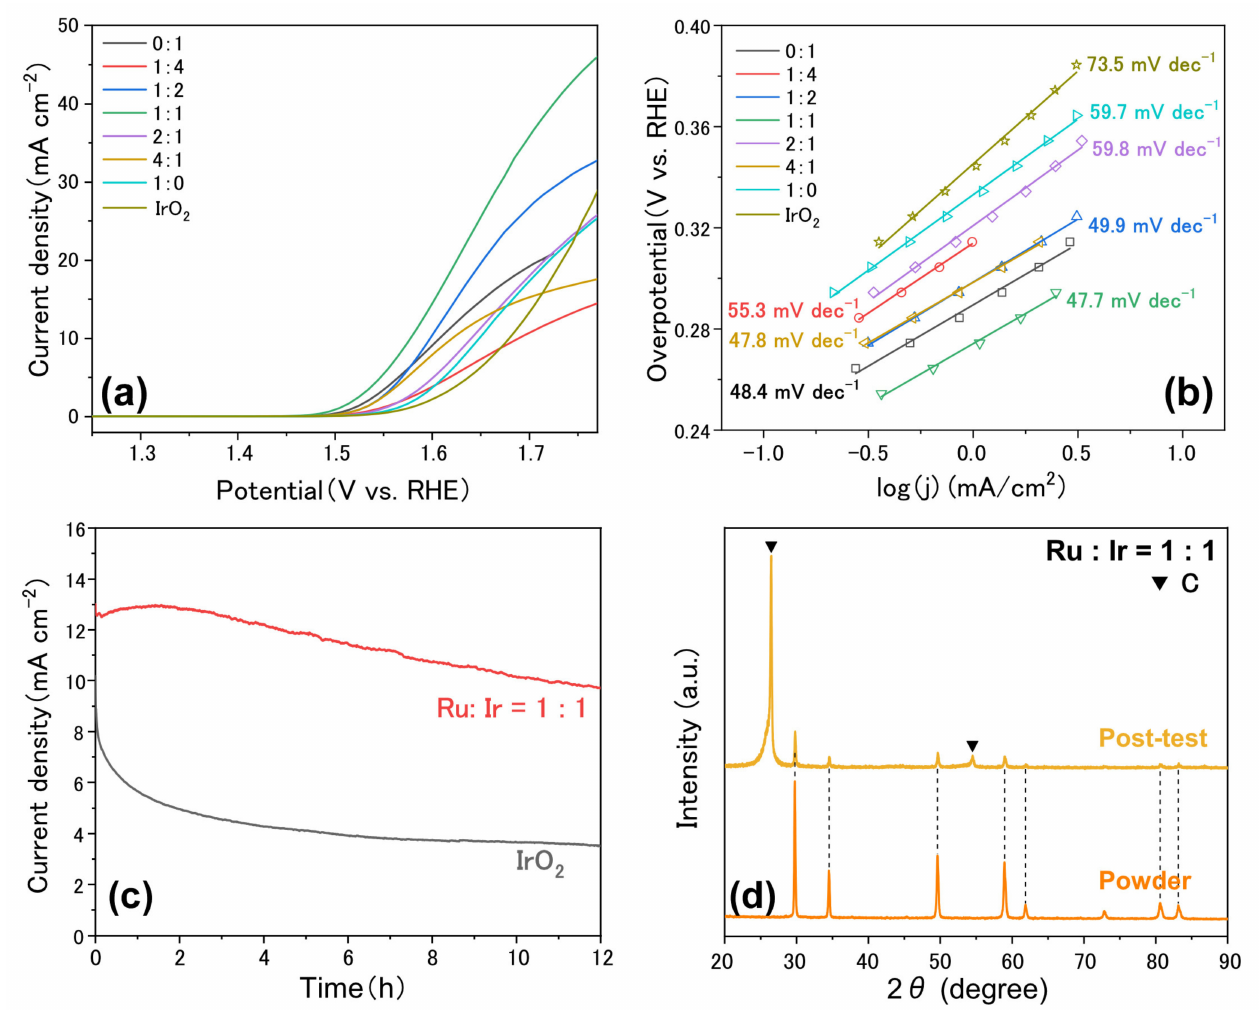
Figure 5. An electrocatalytic OER performance test of catalysts. ( a ) OER polarization curves of Pr 2 (Ru x Ir 1 − x ) 2 O 7 catalysts with different molar ratio of Ru and Ir. ( b ) Tafel plots obtained from the polarization curves in ( a ). ( c ) Chronoamperometric measurement o Pr 2 (Ru 0.5 Ir 0.5 ) 2 O 7 and com- mercial IrO 2 at 10 mA/cm 2 . All the tests were performed in N 2 -saturated 1.0 M KOH solution. ( d ) Comparison of XRD profiles of post-test and as-made power samples, indicating the good phase stability. The carbon signal comes from the attached carbon